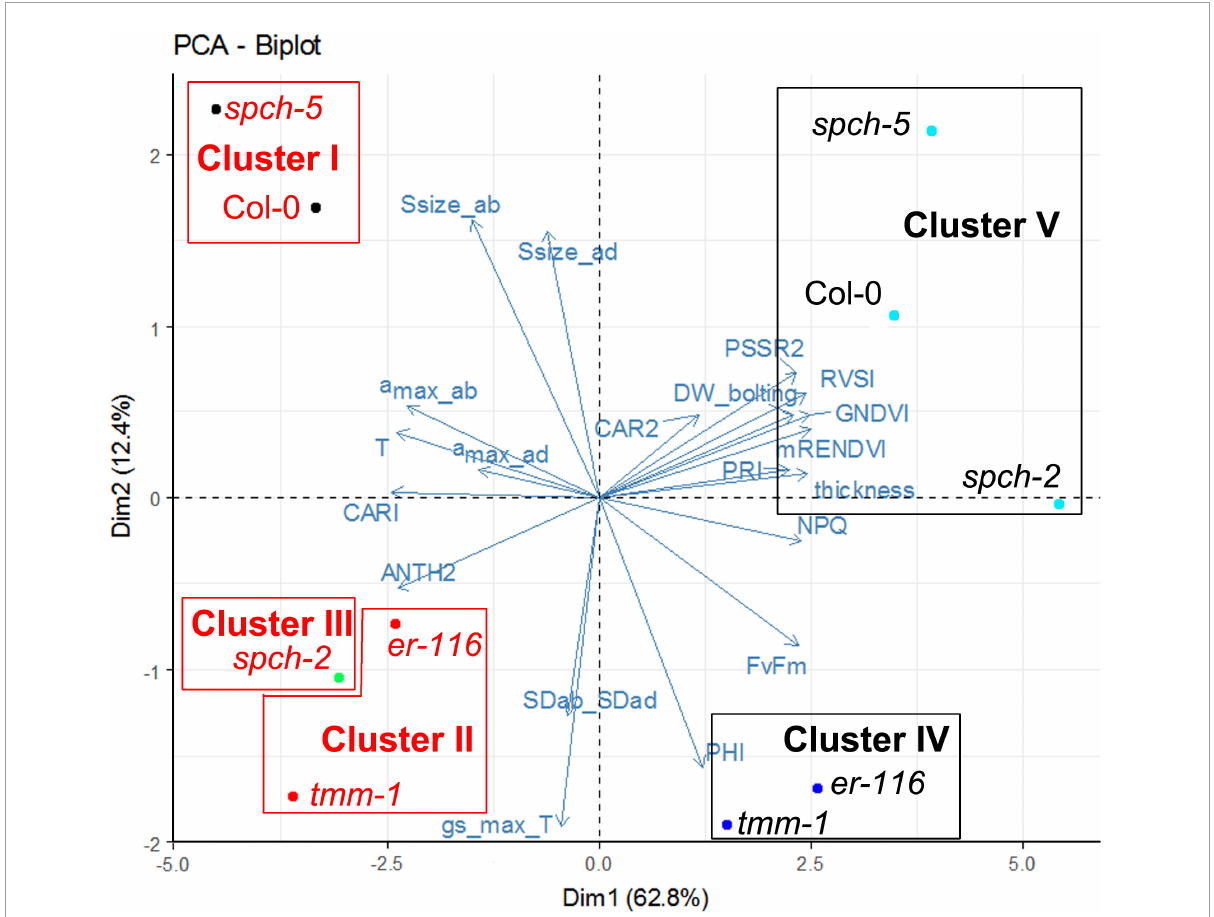
FIGURE7 Clustering of selected genotypes according to their phenotypes grown under optimal and supra-optimal temperature. The Biplot showing the first two variables and the individual factor map of the PCA. Dim1 and Dim2 are first and second principal components, respectively. Their percentage of explained variance is given in parentheses. Genotype color indicates the growth temperature, 22 ◦ C (black) or 30 ◦ C